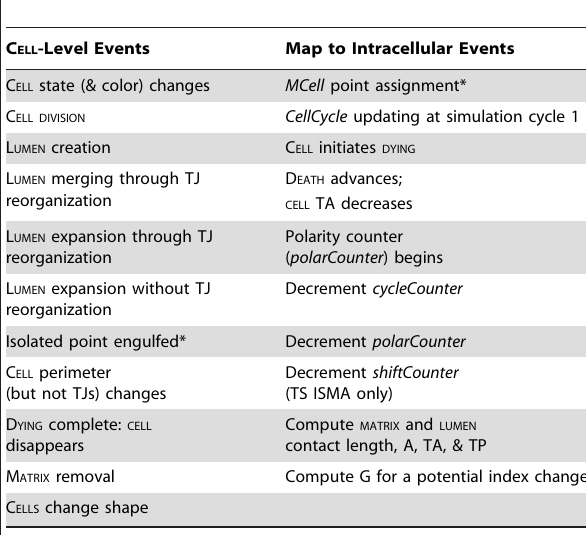
Table 3. C ELL and INTRACELLULAR events that can occur within a simulation